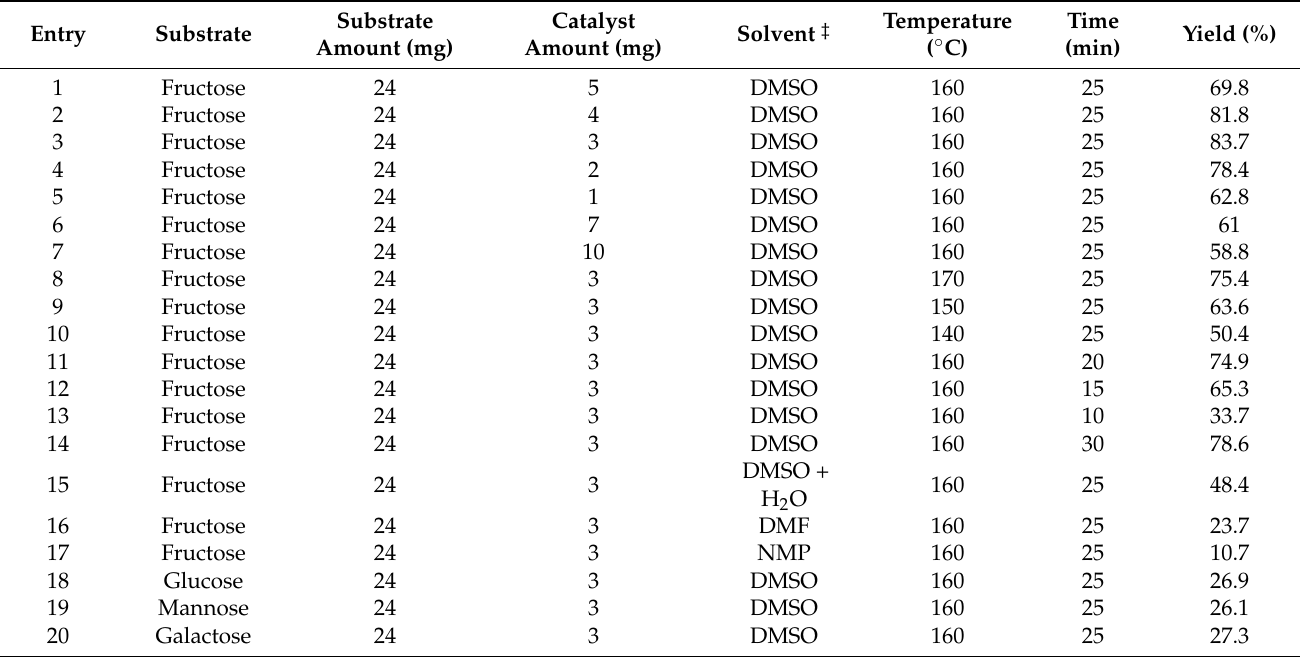
Table 1. Catalytic activity of PHMS-2 material for HMF production under different conditions.